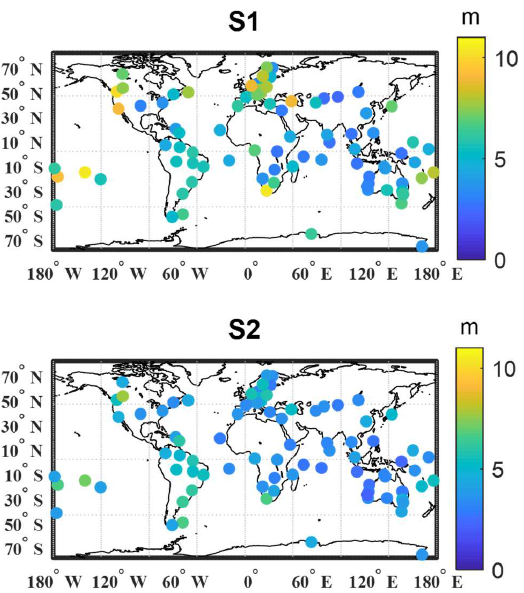
Figure 9. RMS of 3D positioning error at the B1I / B3I frequency for Scheme 1 ( top ) and Scheme 2 ( bottom ).